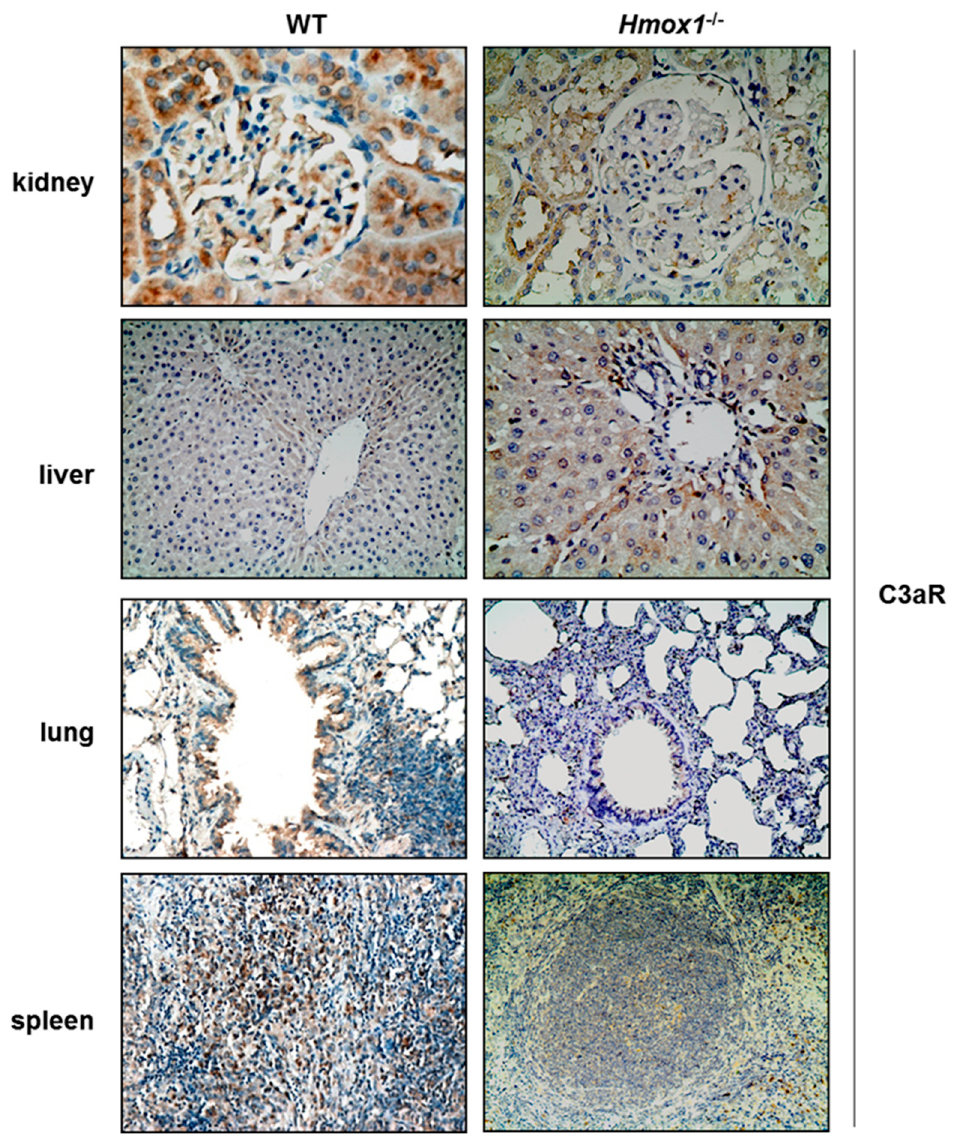
Figure 5. C3aR staining of WT and Hmox1 − / − rat tissue sections. Staining of C3b was detected in all tissue sections examined. Magnification ×200.